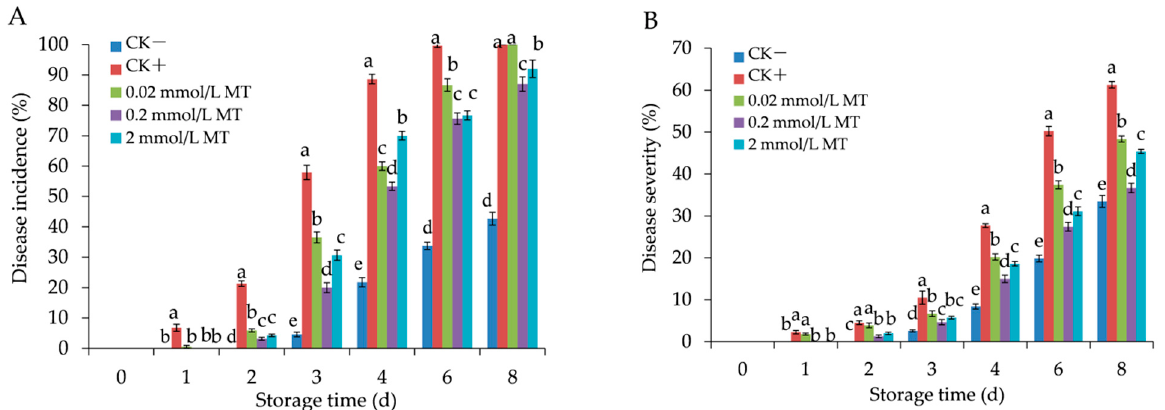
Figure 3. Effect of melatonin treatment on the disease incidence ( A ) and disease severity ( B ) in grape berries. Data represent means ± S.E. ( n = 3). Duncan’s multiple range test was used to analyse significant differences in data, and letters above the bars represent differences at p < 0.05.